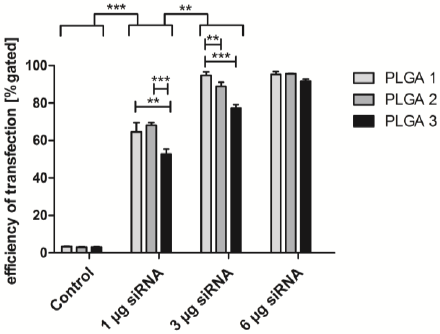
Figure 5. Uptake of siRNA AF 488 by PLGA coatings in EA.hy926. Different amounts of siRNA were combined with PLGA 1–3 and tested for transfection efficiency. Cells were incubated 24 h with respective coated glass slide and afterwards analyzed by flow cytometry. PLGA-coated slides without siRNA served as a control. Statistical analysis was prepared by two-way ANOVA. Each bar represents the mean ± standard error of n = 3. ** indicates statistical significance at a level of p < 0.01; *** indicates statistical significance at a level of p <